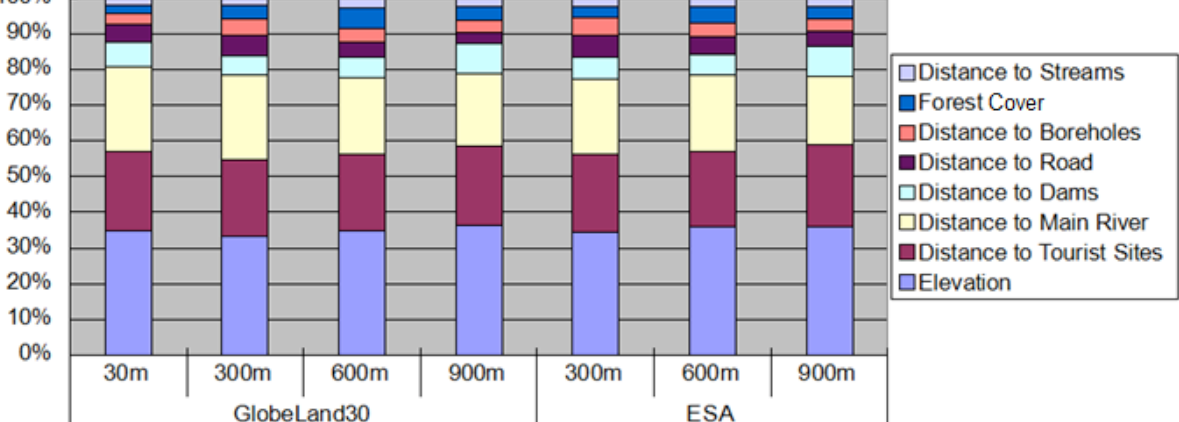
Figure 5. Graph showing the percent contribution of each parameter within all of the models